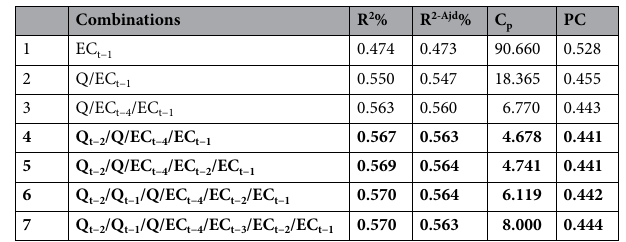
Table 2. Best subset analysis to optimally chosen the input combination of EC in ML models. Significant values are in